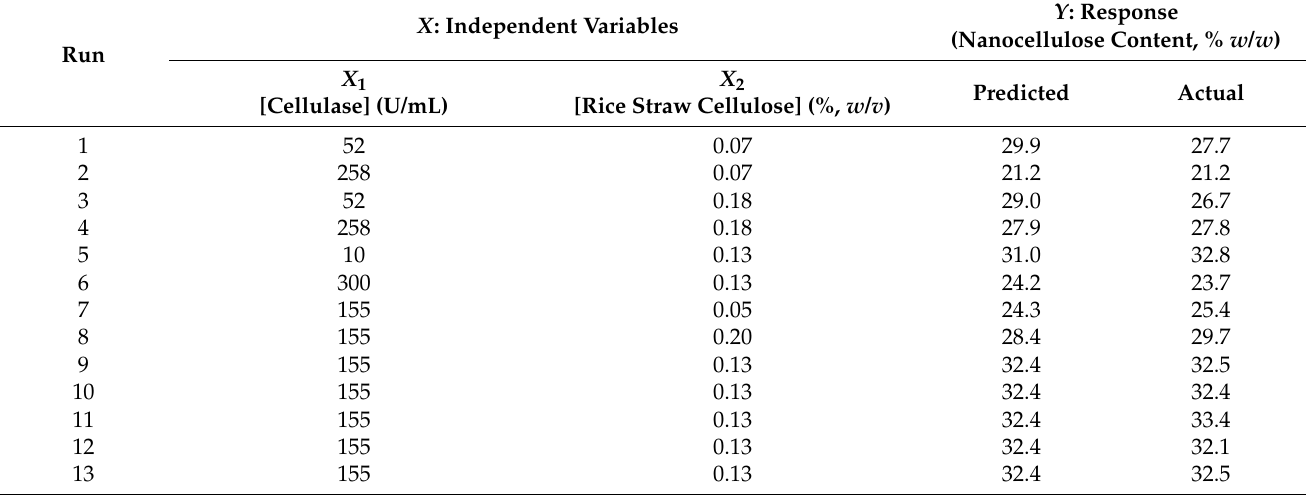
Table 3. Central composite design with independent